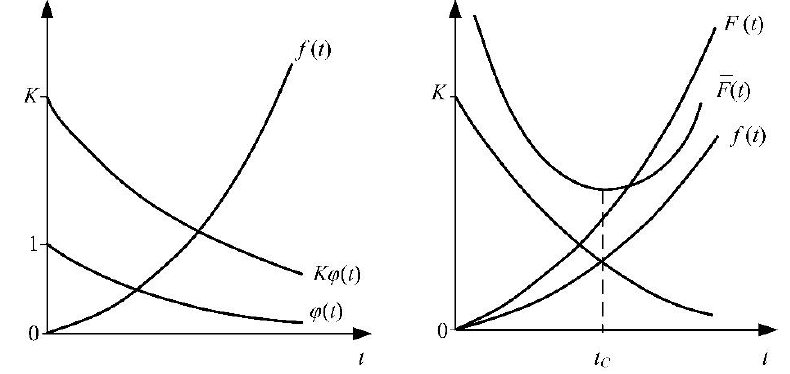
Figure 2. The operational costs of engineering system.